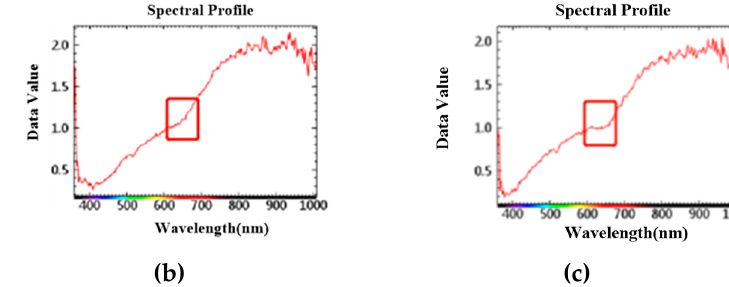
Figure 3. Spectral information of hyperspectral images whose insect information is not obvious in image representation. (( a ). Two-dimensional image information ( b ). Spectral information of soybean not eaten by insects ( c ). Spectral information of soybean eaten by insects).